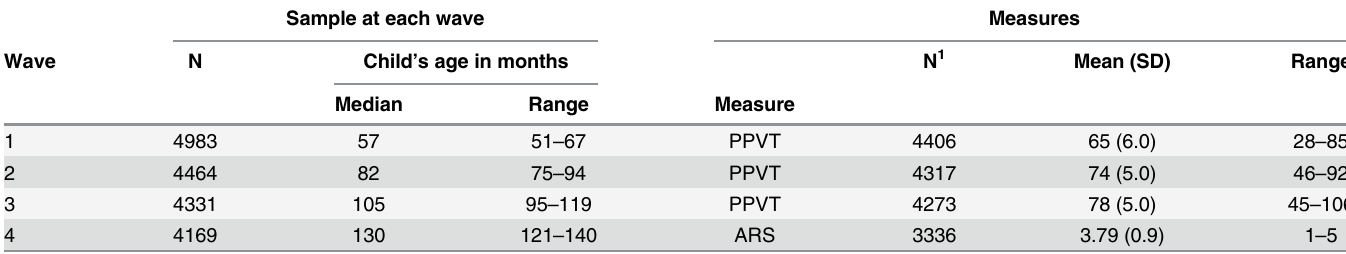
Table 1. Sample size at each wave, children ’ s ages, and PPVT and ARS scores with available